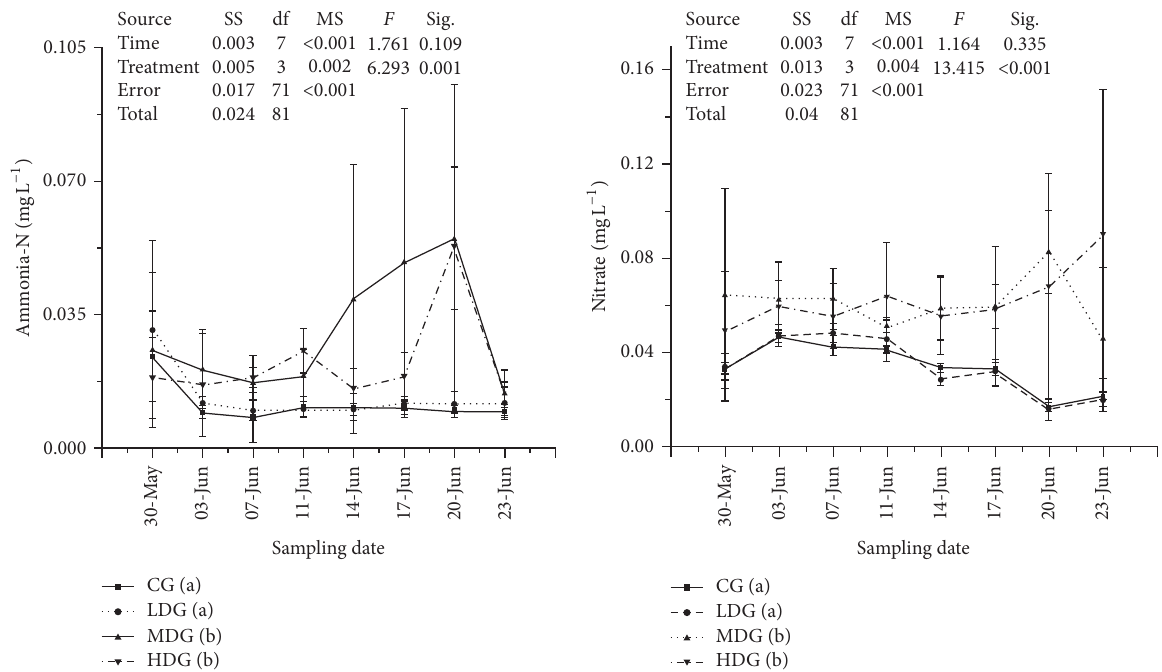
Figure 2: Nutrients values including ammonia and nitrate in each enclosure treatment during sampling points. Values were presented by mean ± STDEV. Treatments with different minuscules mean significant differences between each other and parameters in each treatment from low to high were arranged alphabetically (i.e., treatment with minuscule (a) means the lowest, at 𝑃 < 0.05 , 𝛼 = 0.05 ). SS: type III sum of squares, df: freedom, and MS: mean square.